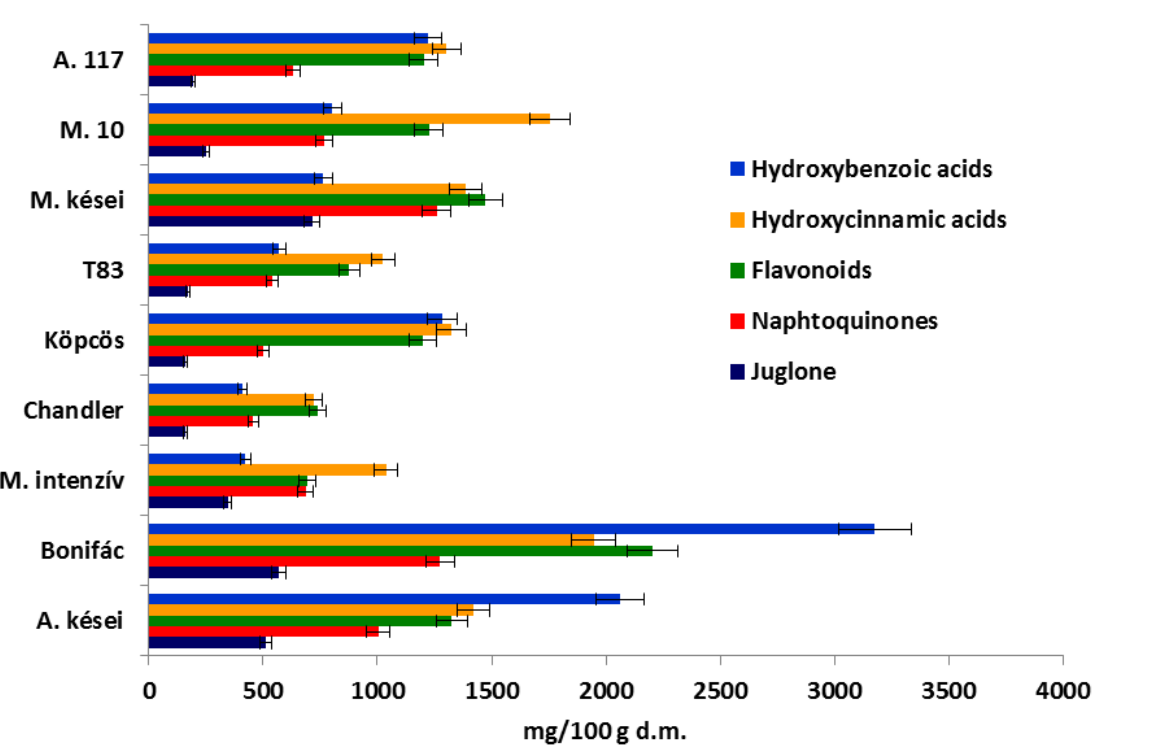
Figure 3. Composition of phenolic compounds measured in the green husk of walnut samples (A.: Alsószentiváni, M.: Milotai).